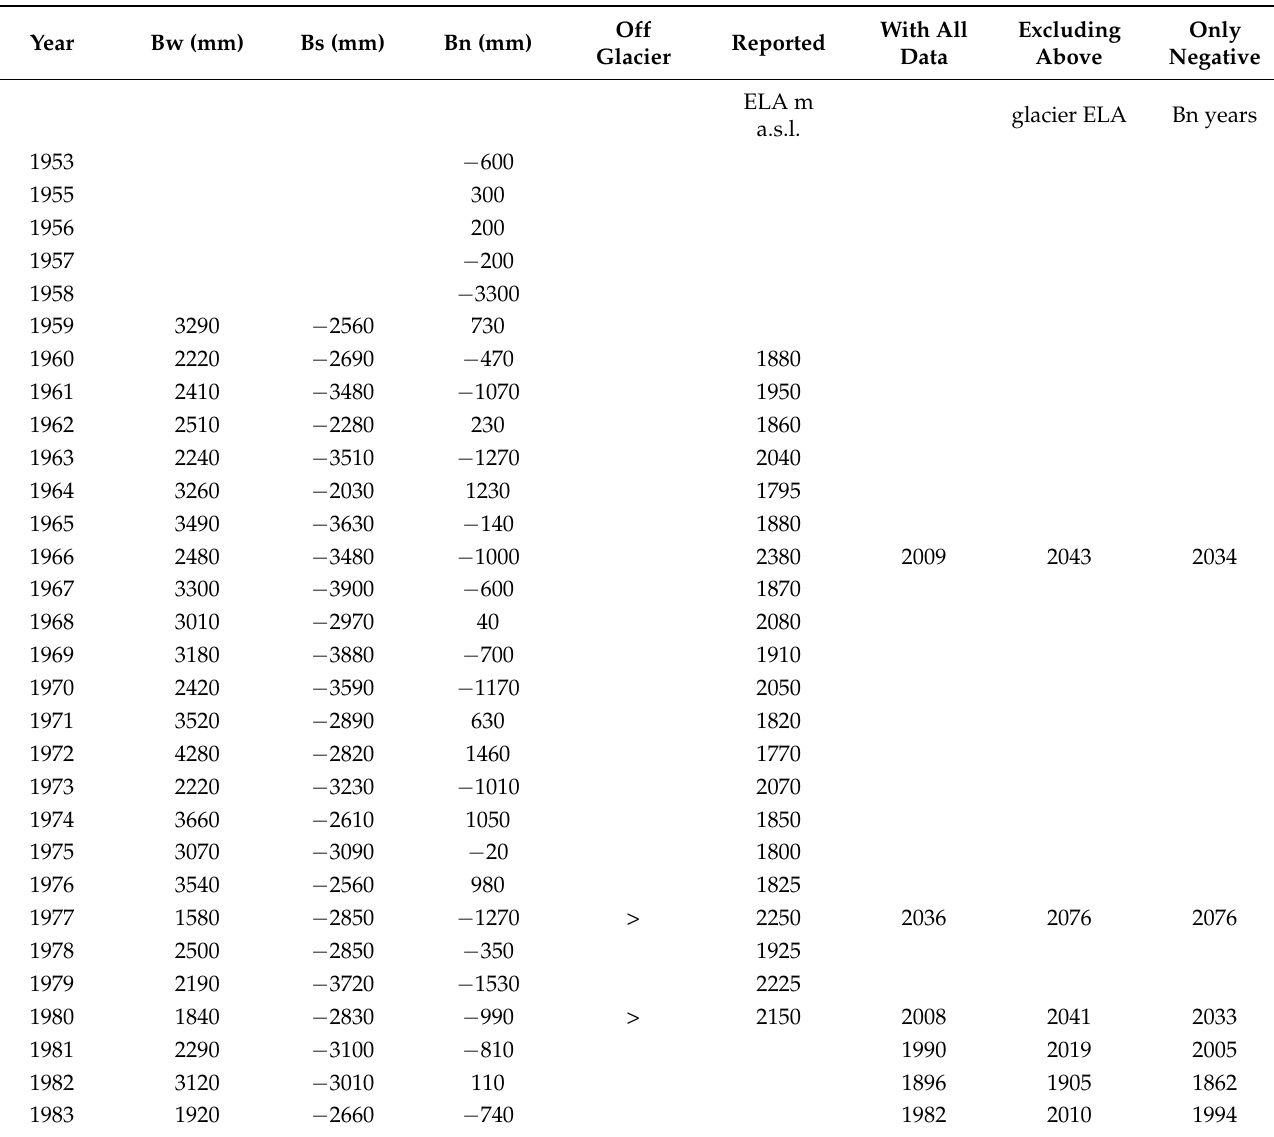
Table 1. Annual mass balance for the South Cascade Glacier as stored at WGMS: last three columns present the results of the ELA estimations from left with all pairs of ELA (m a.s.l.) and Bn (mm w.e.), excluding the pairs for ELA above the glacier, and the last column, with ELA and Bn with only negative